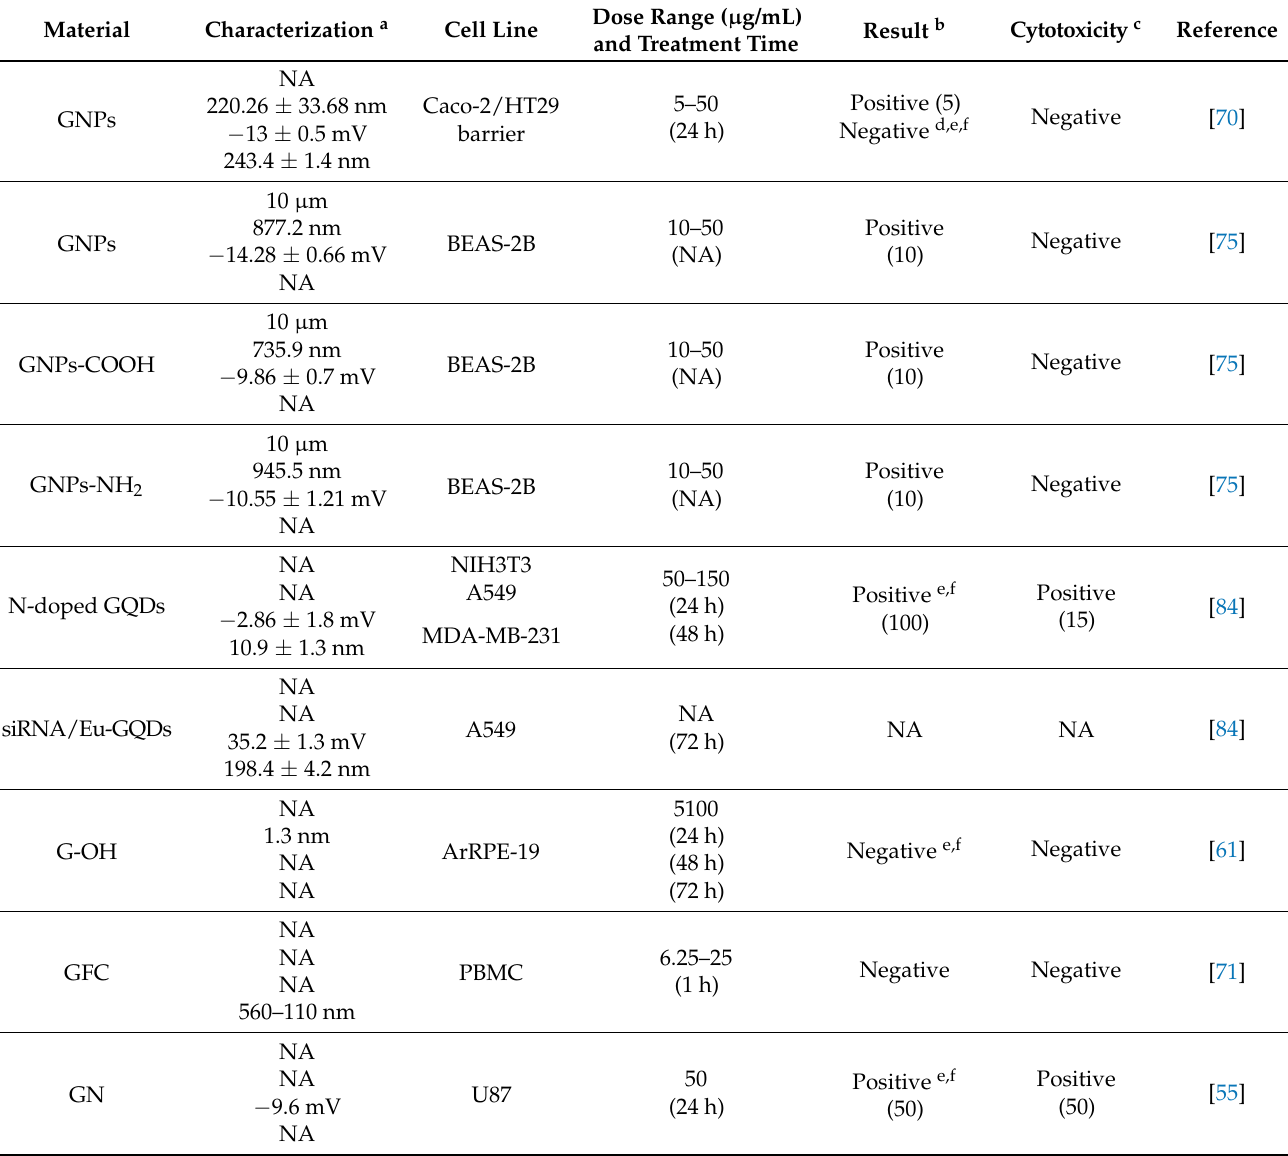
Table 6. In vitro studies assessing the genotoxicity of GNPs, GQDs, G, GFC, and GN using the comet